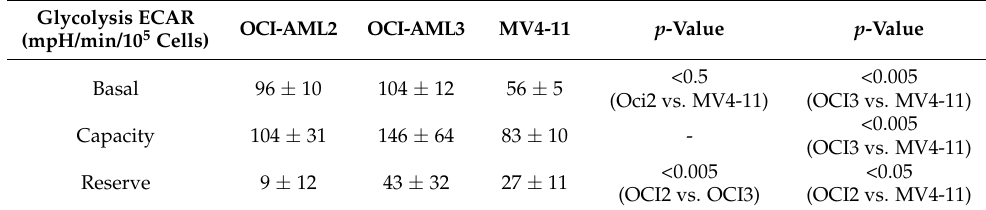
Table 4. Glycolysis values in AML cell lines.